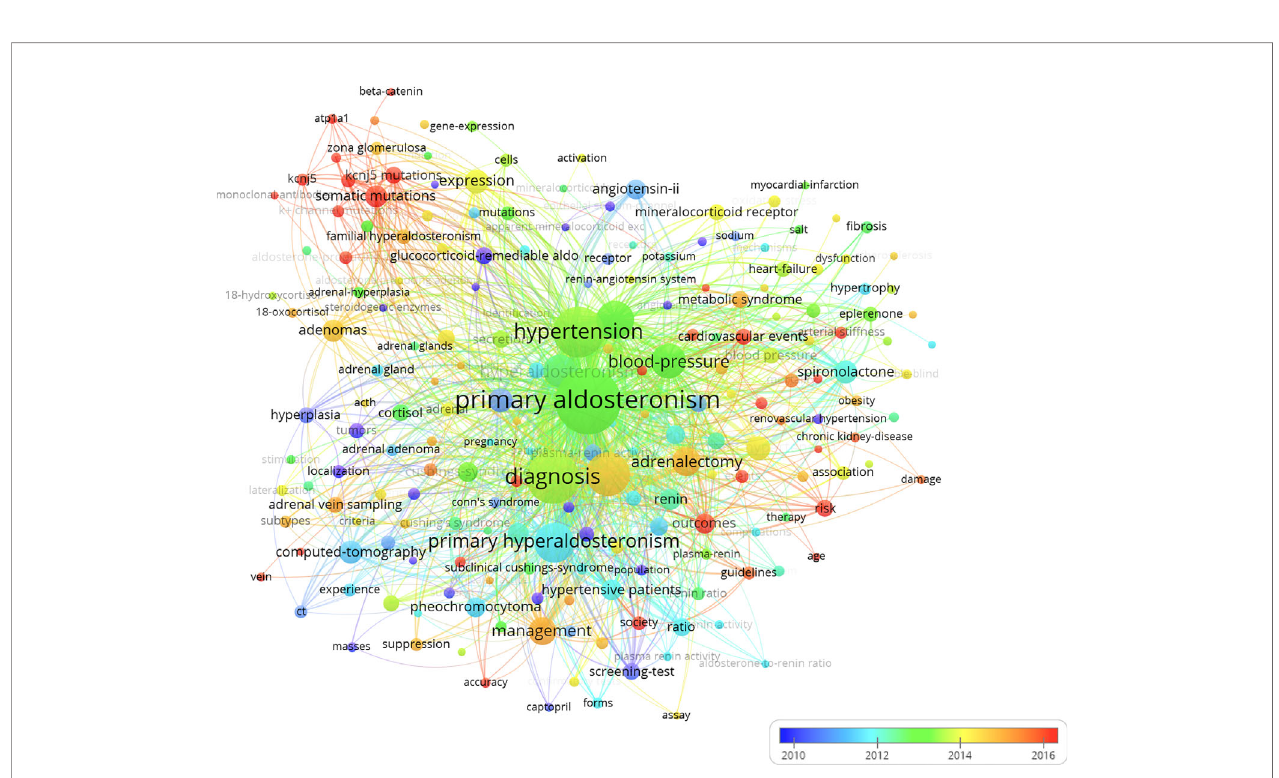
FIGURE 7 | Keywords co-occurrence overlay visualization map. The color of each circle corresponds to the average publication year. The size of a circle is proportional to the frequency of occurrence of the keyword, and the thickness of the connecting line indicates the strength of the keywords co-occurrence link.